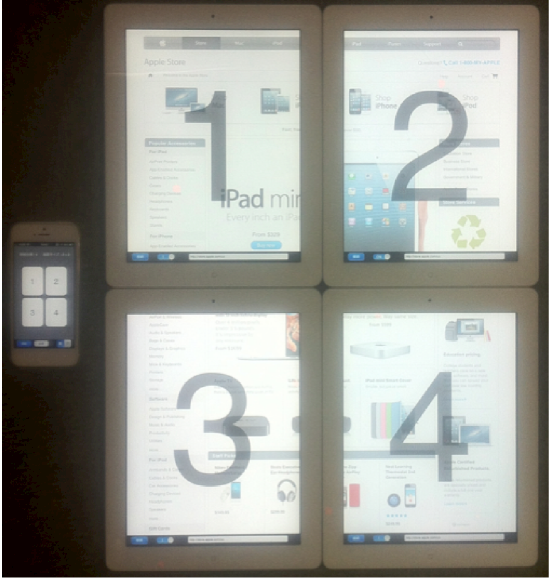
Fig. 3. Using a management device to make a device